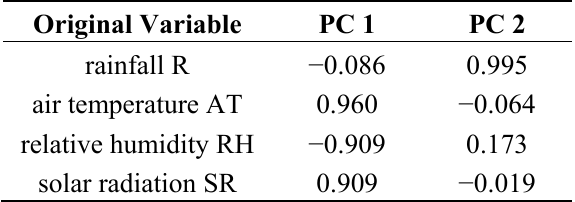
Table 4. Loadings of the four meteorological variables on the two principal